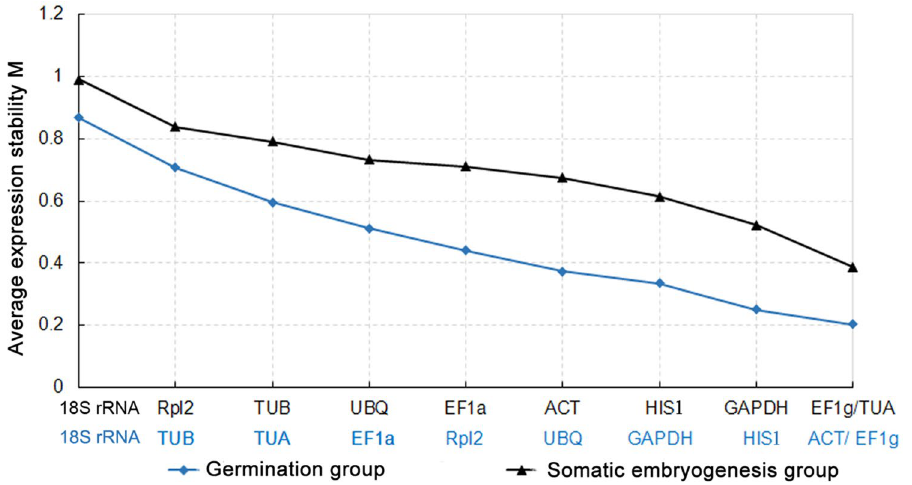
Figure 3. Expression stability and rankings of reference genes in Liriodendron hybrids as calculated by geNorm in the somatic embryogenesis (black) and the germination (blue) groups. Genes with the most constitutive expression are indicated on the right side of the graph, with the less stably expressed genes on the